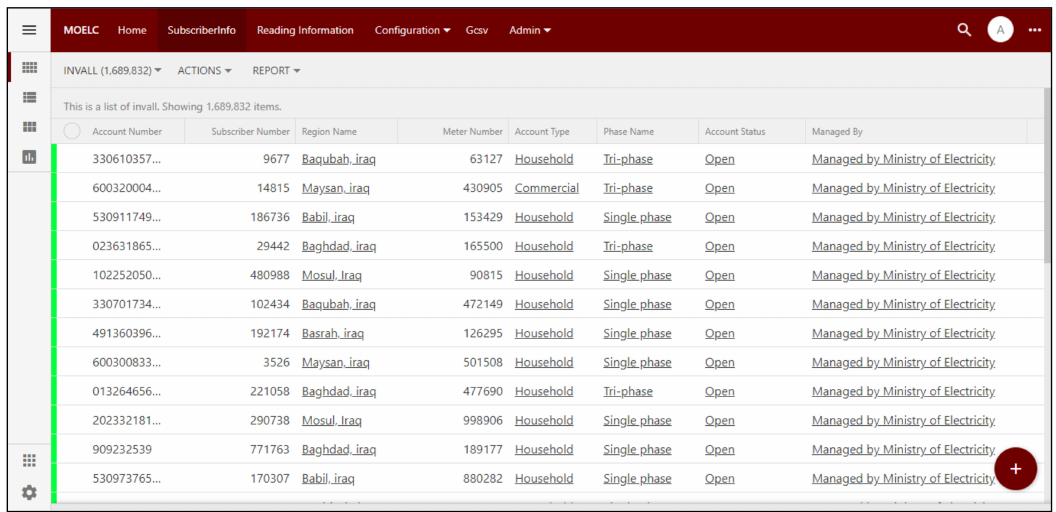
Figure 6. Main Dashboard of